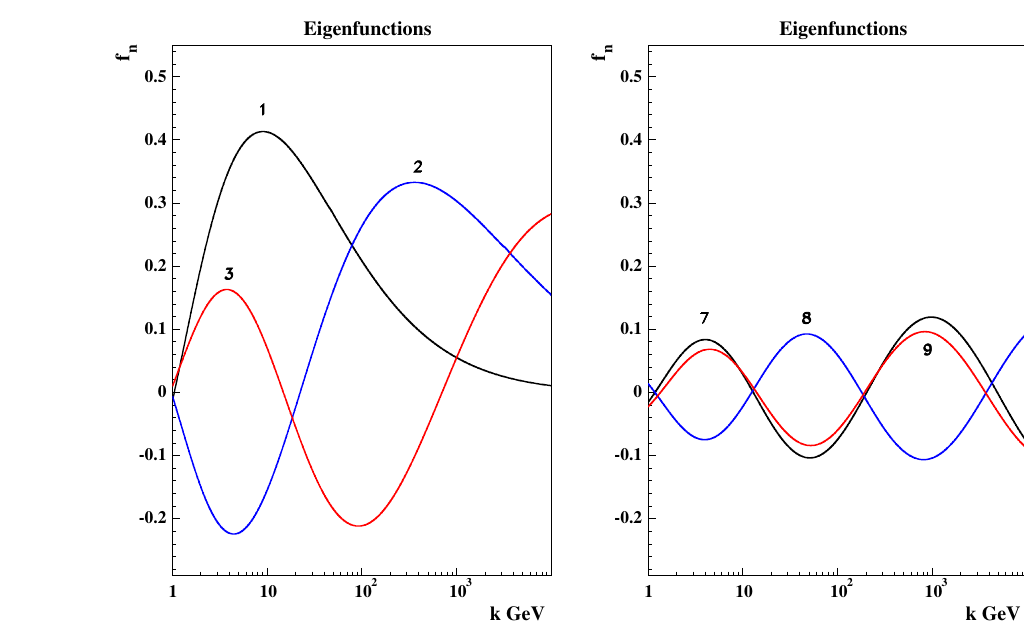
Fig. 12 Eigenfunctions 1, 2, 3, and 7, 8 and 9 in the k region accessible to experiments. The eigenfunctions are plotted with the η n phases given by the AB fit, performed with the b value of the proton impact factor